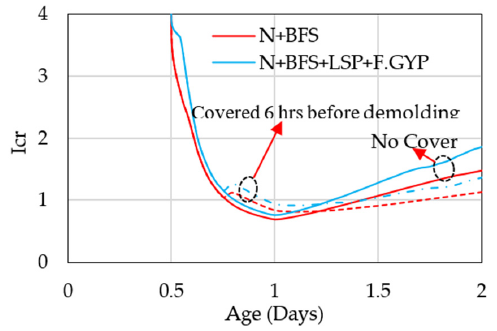
Figure 15. Thermal cracking index at the high cracking region for the covered and uncovered precast concrete